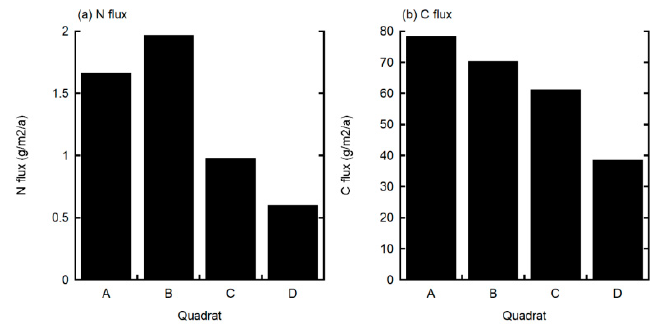
Mean ± SE are shown. Significance of di ff erence between litter components was tested by Kruskal-Wallis test and the following Mann–Whitney U-test with Bonferroni correction. Means sharing the same letter (a, b) are not significantly di ff erent ( α = 0.05). Data of other parts are excluded from multiple comparison. n = 8, excluding quadrats without litter samples of each category.